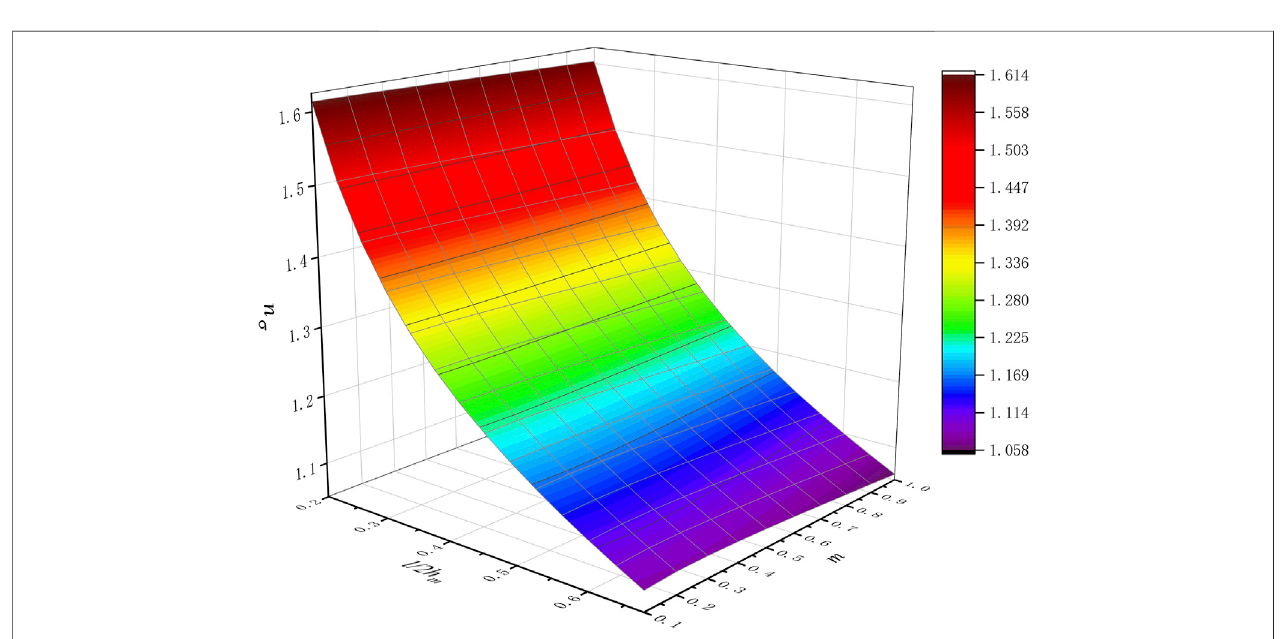
FIGURE 6 | Effect of friction factor and relative reduction on the neutral point position.